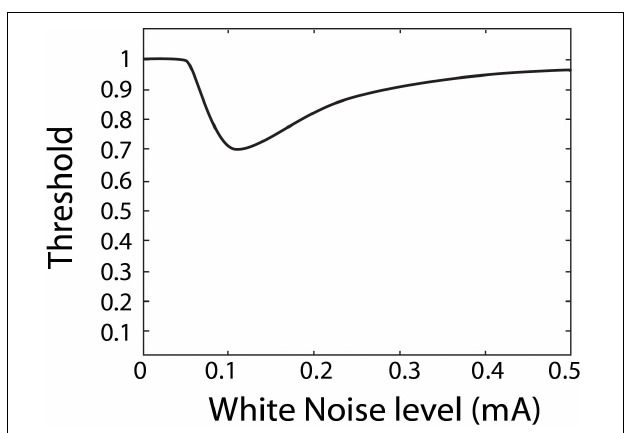
FIGURE 1 | Graph to show characteristic shape of SR the curve in threshold against noise level.